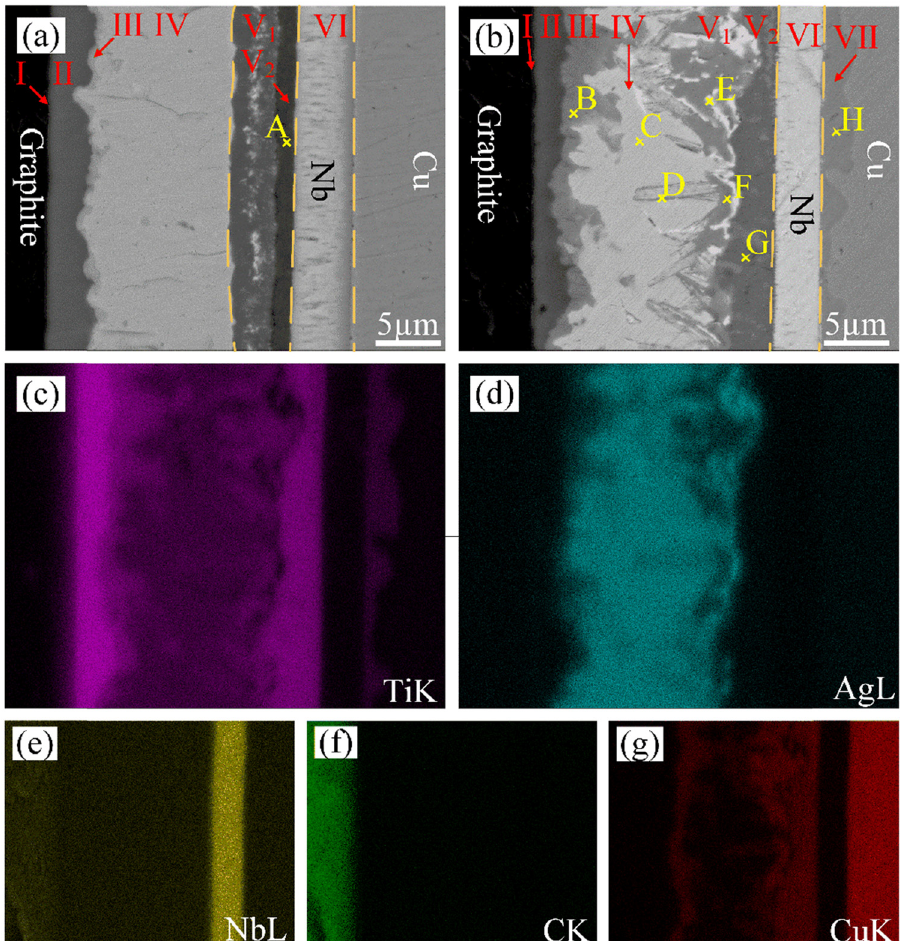
Figure 4: Microstructure of the graphite/Cu joint bonded with Ti/Ag/Nb composite interlayer at 850°C: ( a ) 60 min, ( b ) 90 min, and elemental analysis results ( b – g ) of the joint for 90